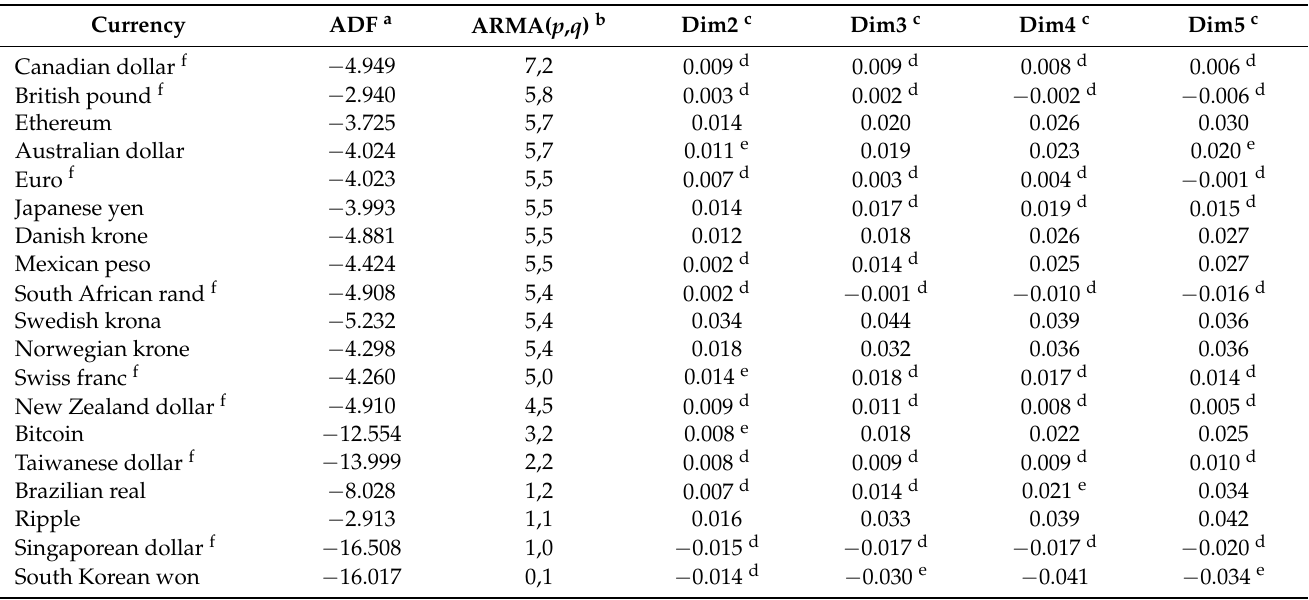
Table 3. Augmented Dickey–Fuller test and ARMA( p , q )